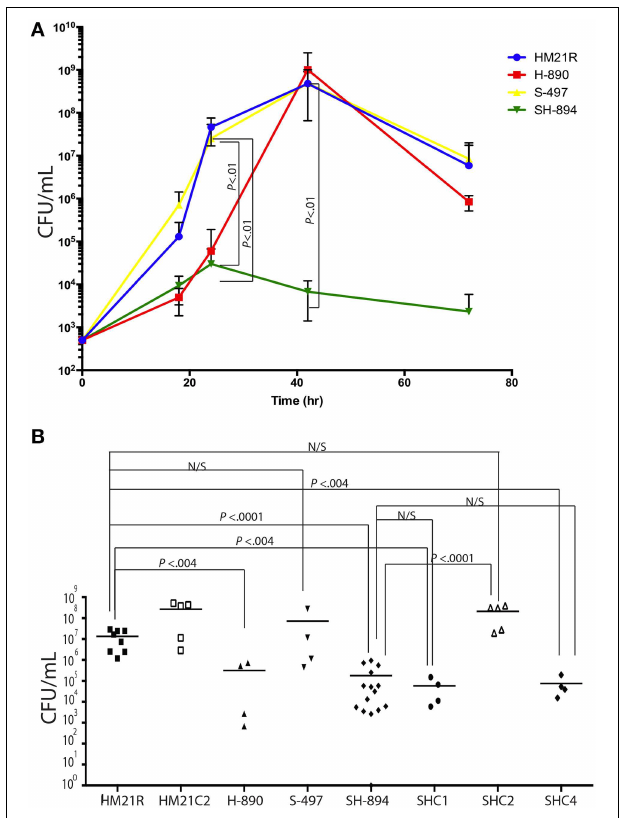
FIGURE 3 | In vitro and in vivo proliferation of iron utilization mutants. A time course of growth in blood of Hm21R (blue); H-890 (red), the hgpB mutant; S-497 (yellow), the siderophore mutant; and SH-894 (green), the double mutant at 18, 24, 42, and 72h is shown (A) . This revealed that in blood either viuB or hgpB suffice for growth. The symbols represent the average of 3 leech gut samples (A) . Colonization of iron utilization mutants and complemented strains within the leech crop is shown (B) . Each symbol represents the colonization level in one leech. The statistically significant difference between the parent strain and each mutant was performed using a Mann–Whitney test. Bonferroni corrections were preformed and the critical threshold is 0.007. N/S, not